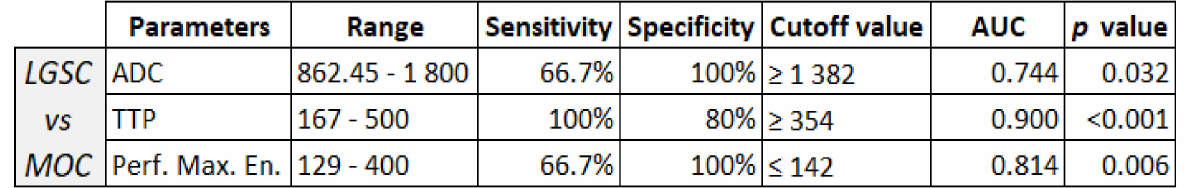
Scheme 4. The results obtained during the analysis of three ROC curves for three quantitative methods to identify the level of EOC disease progression in the studied patients (LGSC, MOC).